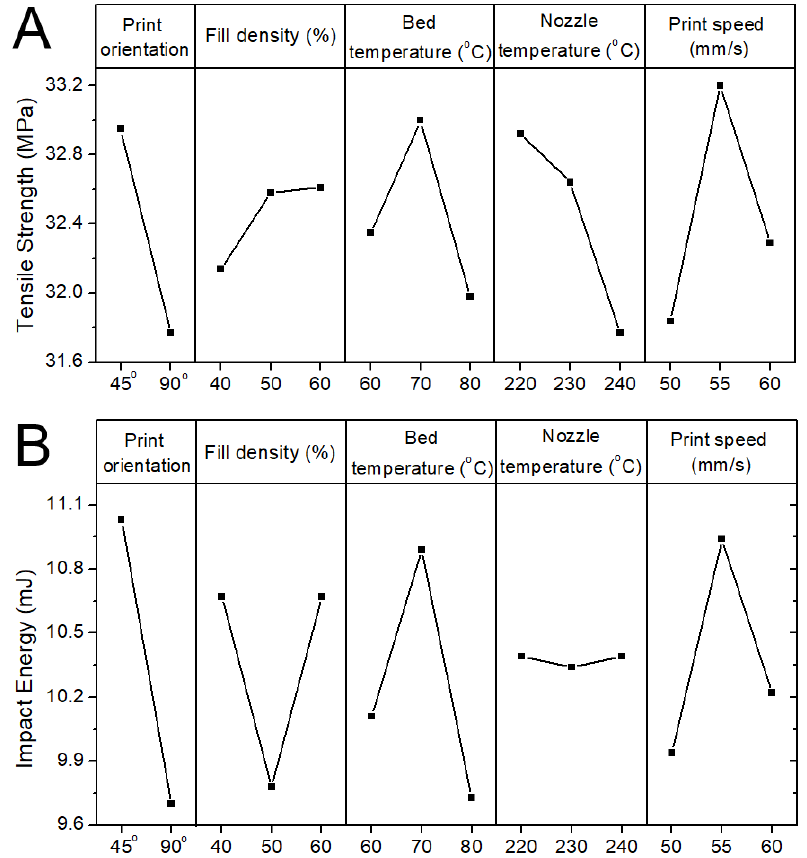
Figure 6. Main e ff ect plots of the CFR-PLA parts for ( A ) tensile tests and ( B ) impact Figure 6. Main effect plots of the CFR-PLA parts for ( A ) tensile tests and ( B ) impact tests.